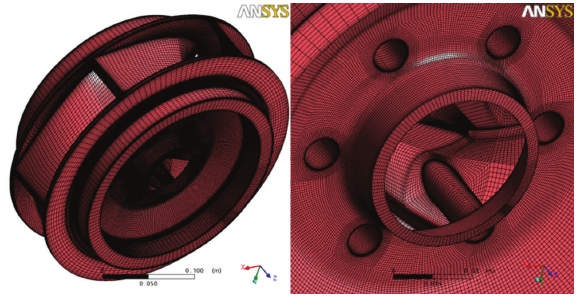
Figure 7: Mesh visualization of